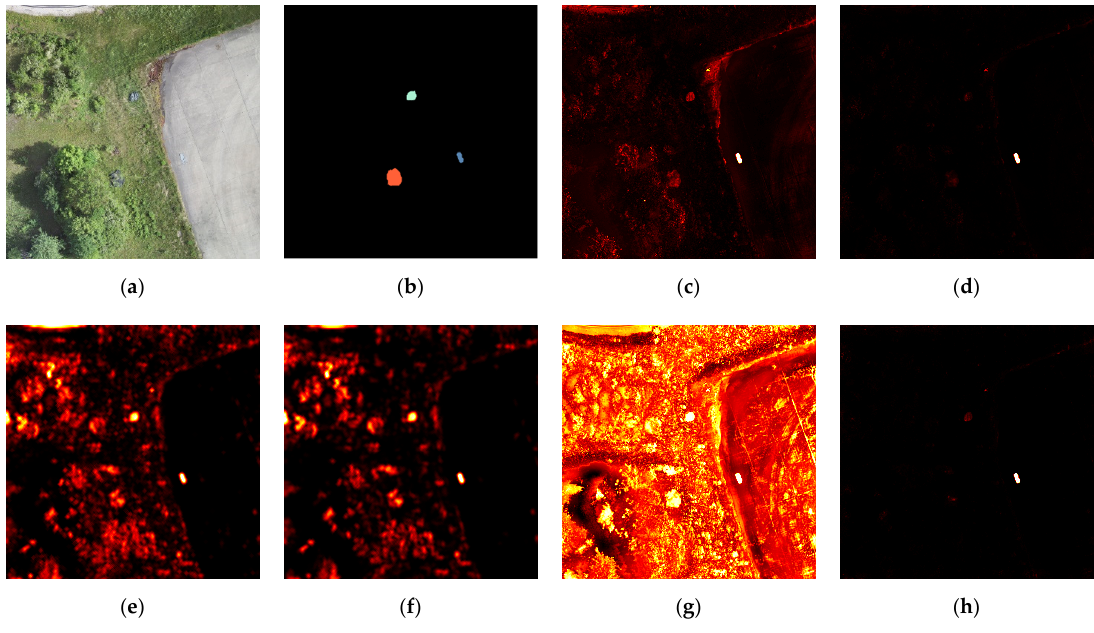
Figure 8. Detection maps of all evaluated methods applied on an exemplary capture of the raw version of MUCAD. ( a ) VIS; ( b ) ground truth; ( c ) RX; ( d ) LRX (21, 61); ( e ) AED (200); ( f ) AED-F (200); ( g ) LPD (11, 31); ( h ) CRD (21, 31). The parameter configurations (in parentheses) correspond either to the inclusion and exclusion window or to the area of connected components to be removed.